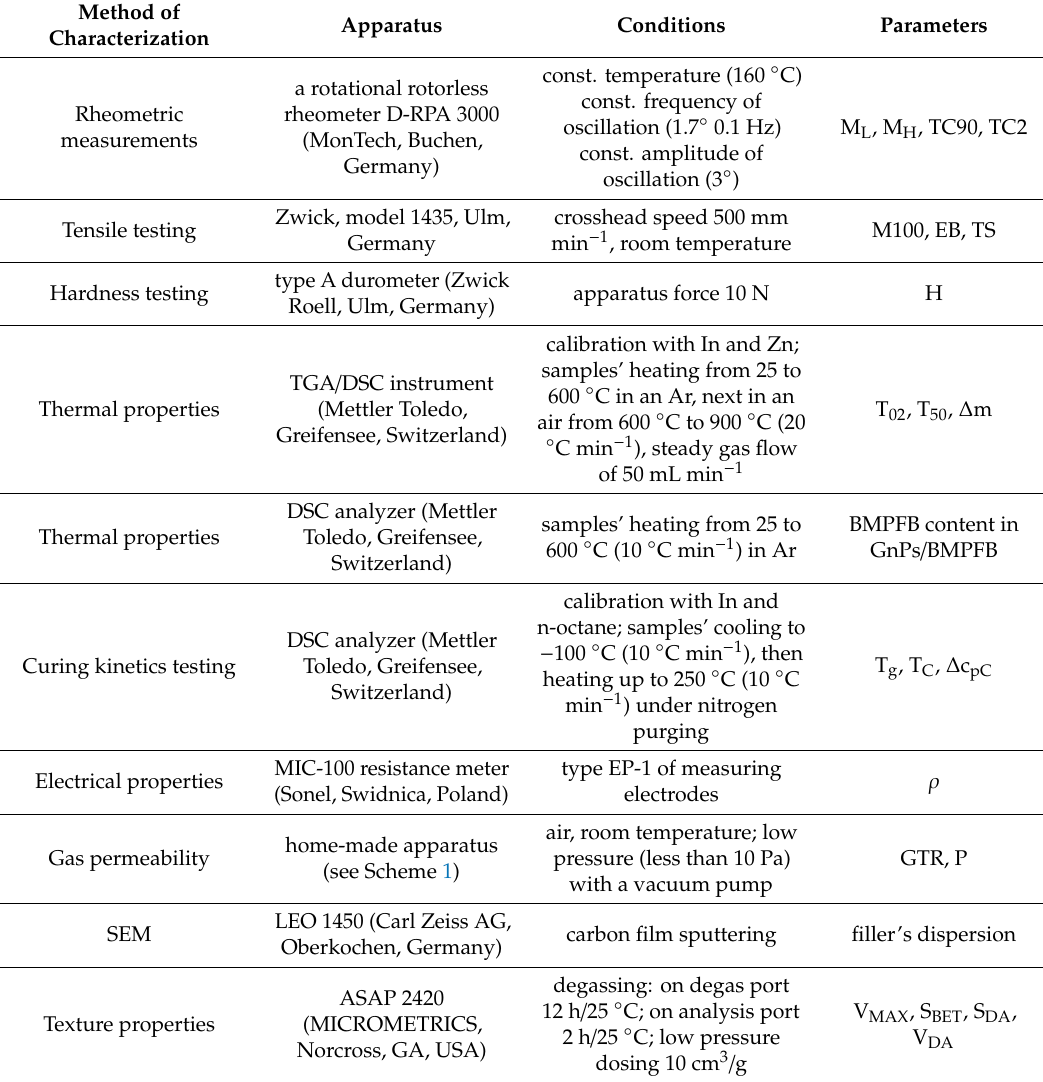
rubber composites. Table 2. Methods of samples’